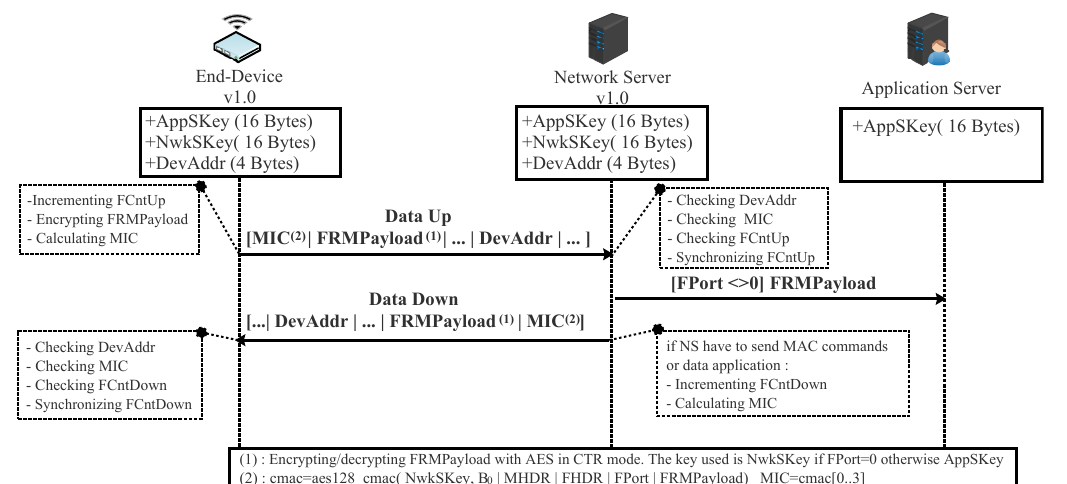
Figure 6. OTA or ABP end-device exchanging messages with a network server in scenario